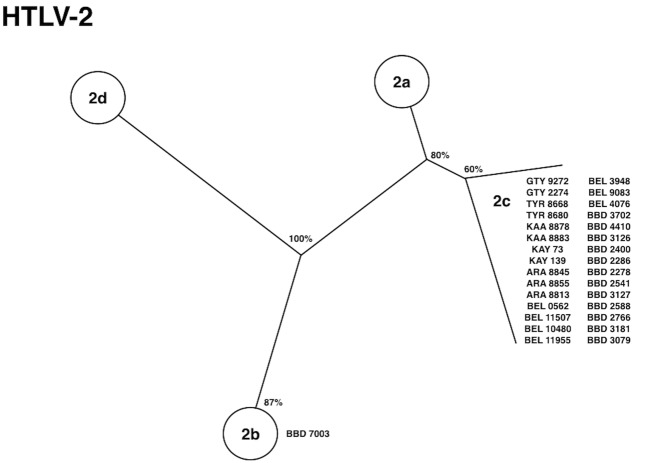
Phylogenetic tree showing HTLV-2 subtypes isolated from native Indian communities from the Amazon region of Brazil [adapted from Ishak et al. (1995) and Vallinoto et al. (2002)].